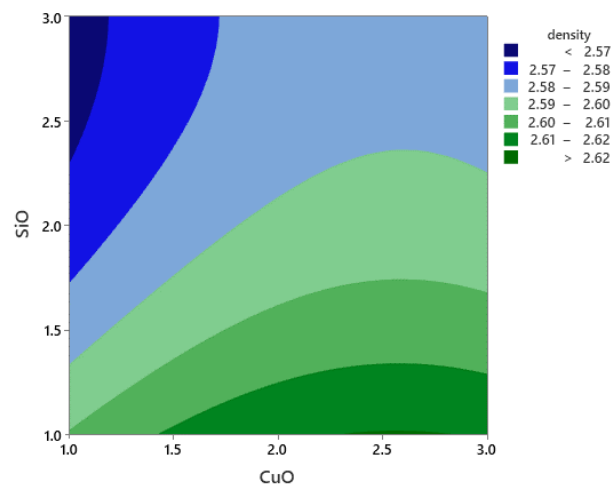
Figure 15. Contour plot for density.